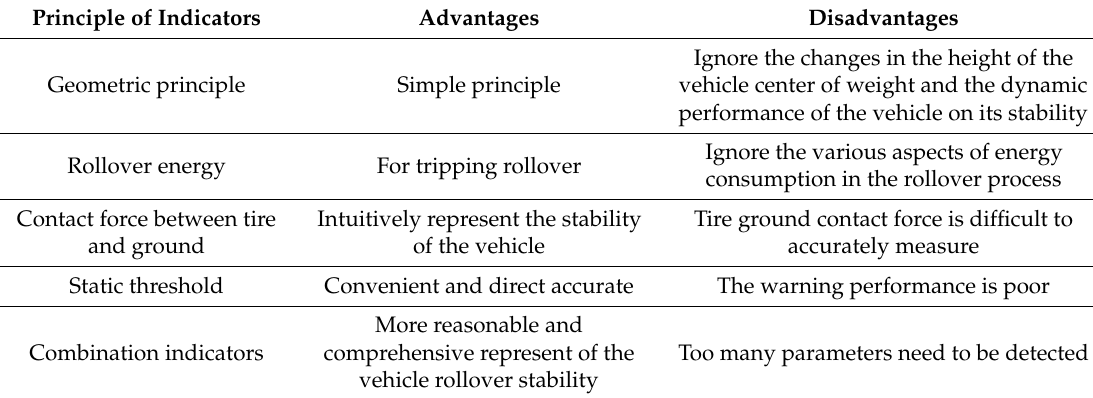
Table 1. Evaluation of various instability predictors indicators.